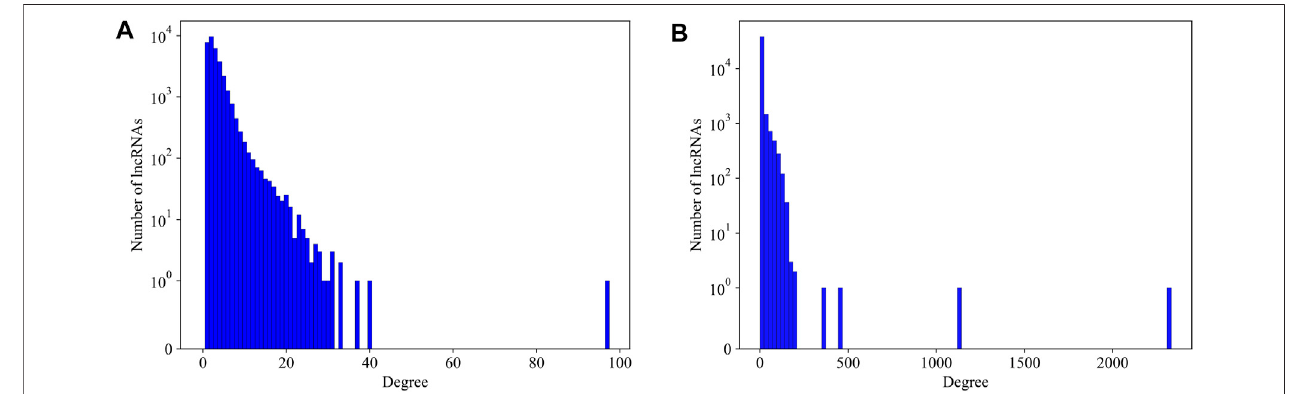
FIGURE3| Thedegree distributionoflncRNAs inmouse networkand humannetwork,respectively. (A) Thedegree distributionoflncRNAs inmouse network; (B) The degree distribution of lncRNAs in human network. No protein-protein interaction is counted in producing these distributions.